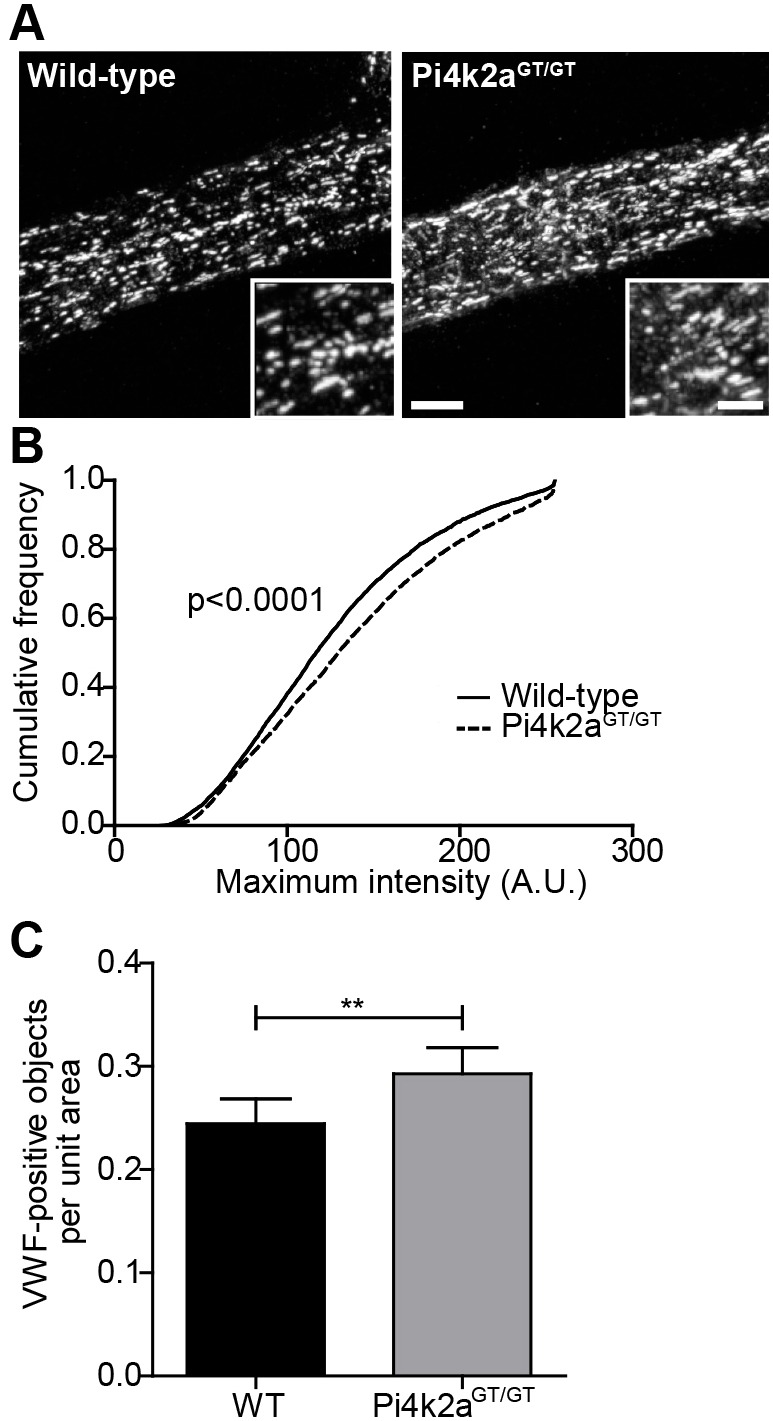
Confocal analysis of WPBs in the retinal vasculature of PI4KIIα-deficient mice. (A) Representative maximum intensity projections of retinal blood vessels from wild-type or Pi4k2aGT/GT mice, showing VWF immunolabelling. Scale bars: 10 µm or 2 µm (insert). (B) Cumulative frequency distribution of the maximum intensity of VWF-positive objects in similar images from wild-type or Pi4k2aGT/GT mice, analysed by Mann–Whitney test. (C) The number of VWF-positive objects per unit area analysed by unpaired t-test. **P<0.01. A.U., arbitrary units.